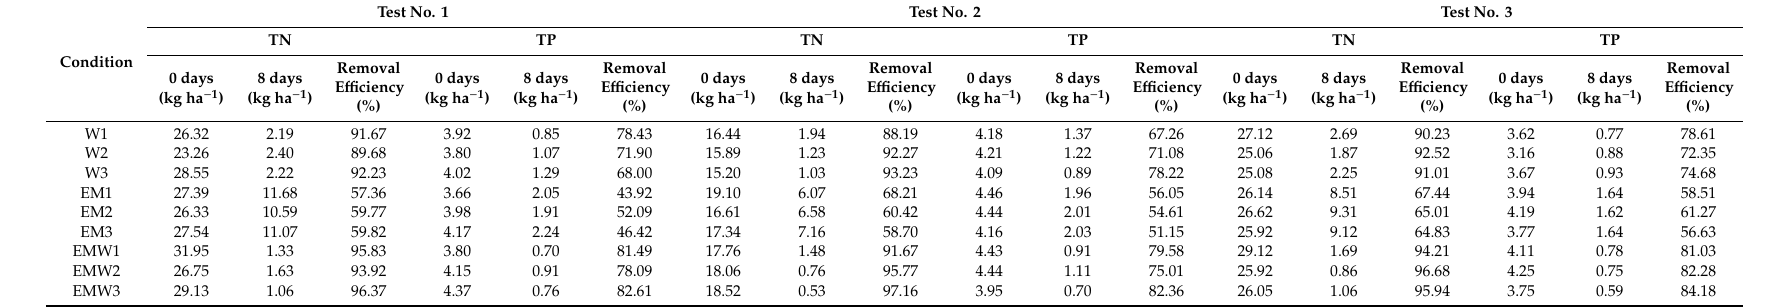
Table 6. Mass removal e ffi ciencies of nitrogen and phosphorus under various experimental